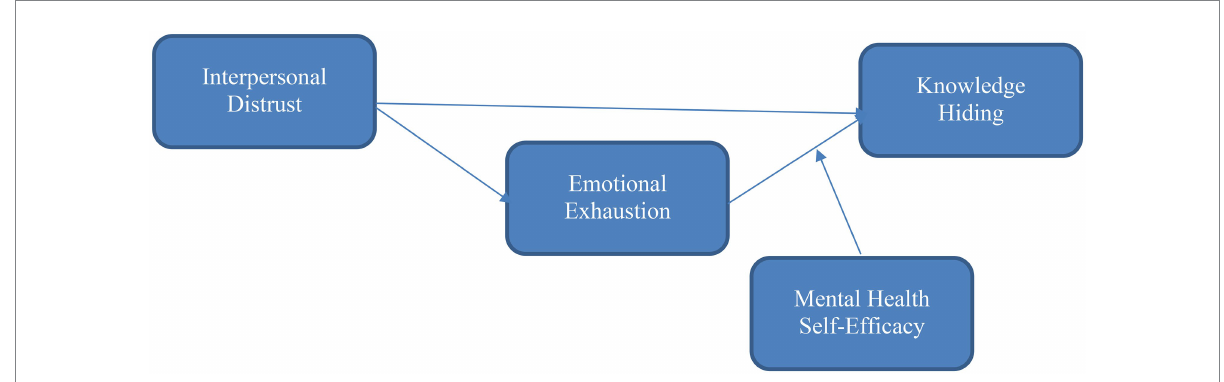
FIGURE 1 Conceptual